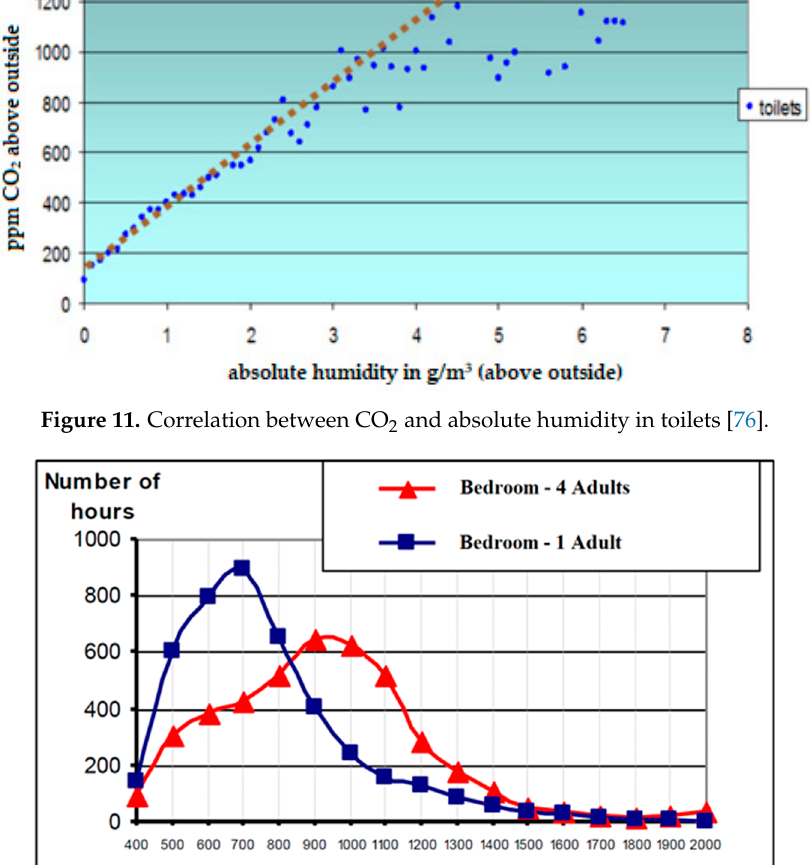
Figure 12. Hourly CO 2 concentration measurements in two different bedrooms with low occupancy (1 adult) and high occupancy (4 adults) periods annually [76].